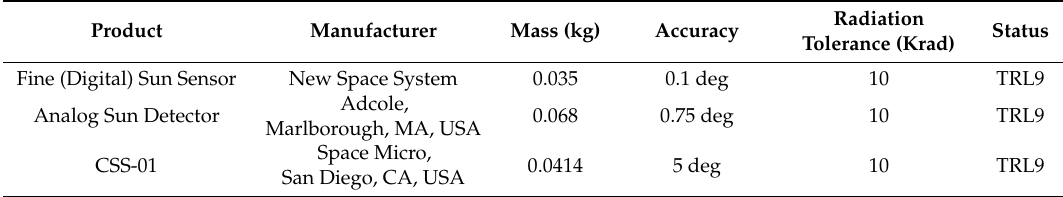
Table 19. Sun Sensor Performance Data [23].